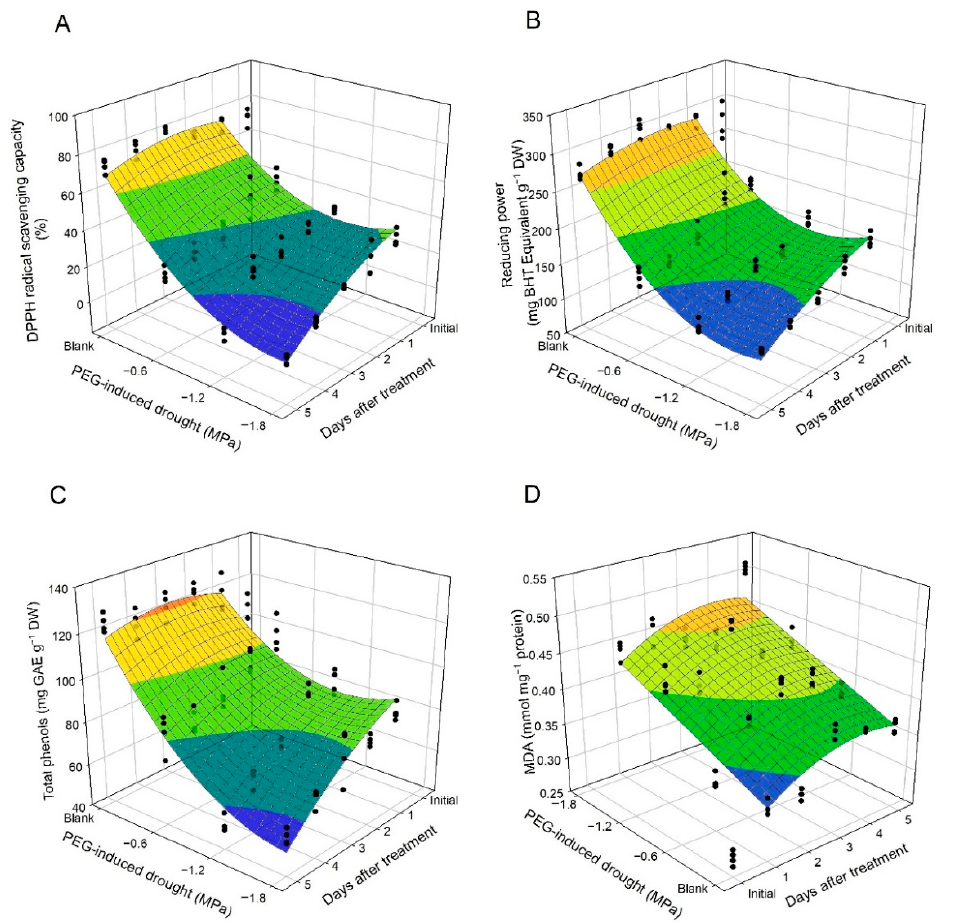
Figure 4. Scatter plots and regression surfaces of DPPH radical scavenging capacity ( A ), reducing power ( B ), total phenols ( C ), and MDA ( D ) content in tea leaf discs as affected by PEG-induced osmotic stress during a 5-day period.